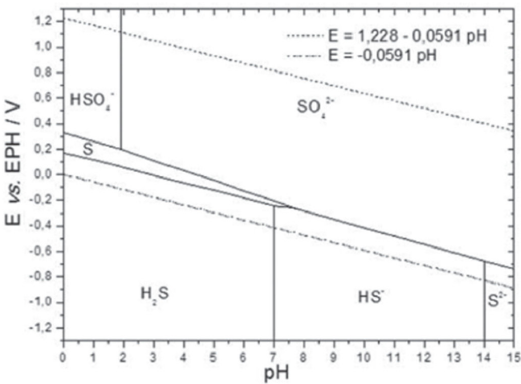
Figure 9. Diagram E vs. pH for thiosulphate and H equilibrium in aqueous solutions 62